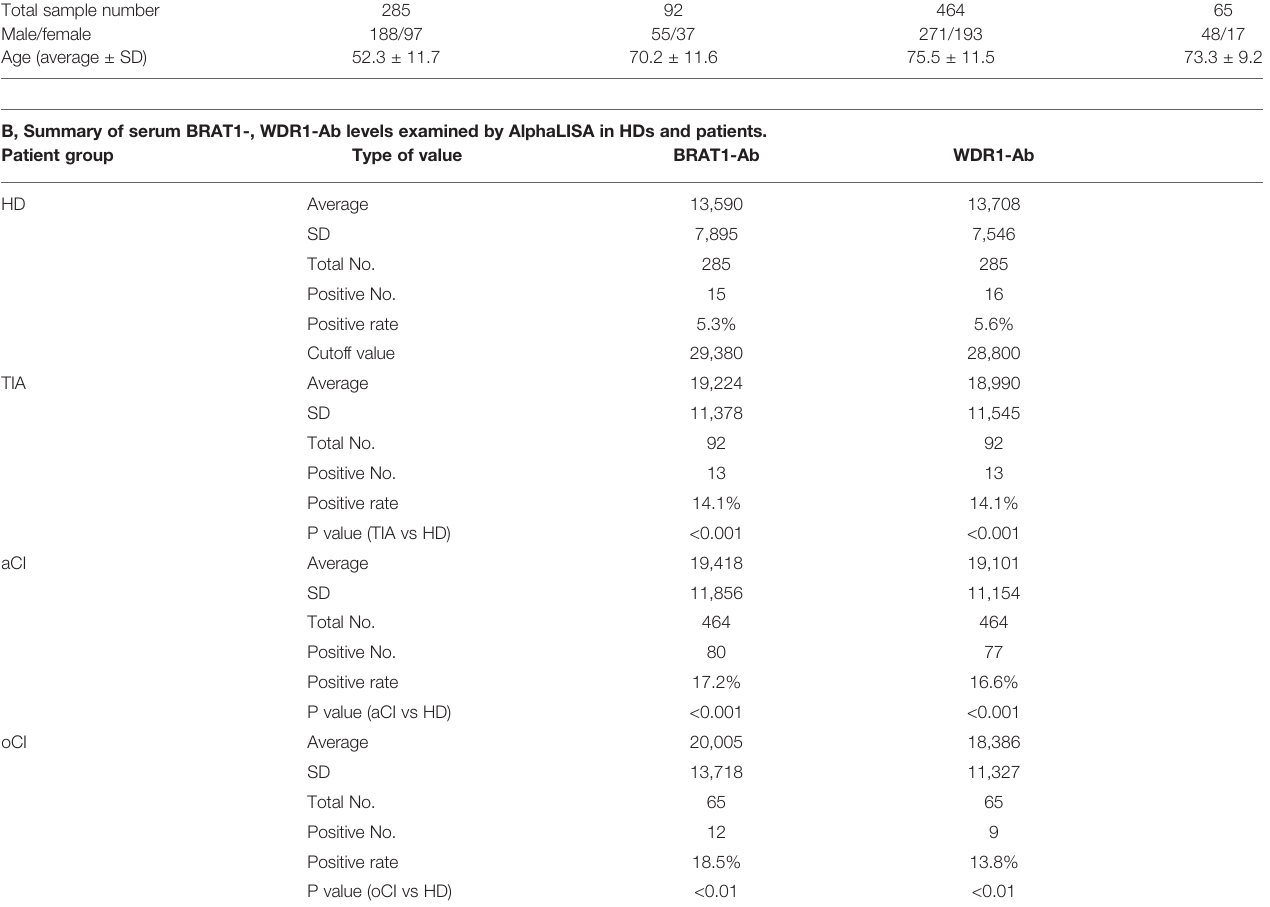
TABLE 1 | Comparison of serum BRAT1-, and WDR1-Ab levels between HDs and patients with TIA, aCI or oCI examined by AlphaLISA. A, Subject information on HDs and patients. Sample